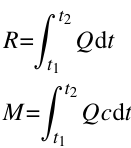
Figure 7. Concentrations of K + , Na + , Cl − , HCO